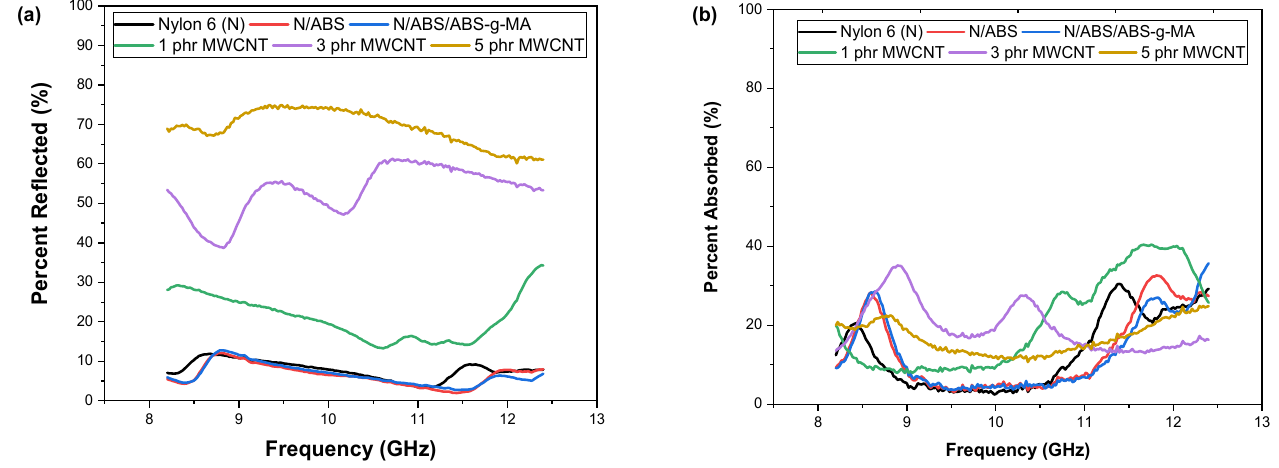
Figure 5. Contribution of reflection and absorption to electromagnetic wave attenuation for Nylon 6, blends, and nanocomposites. ( a ) Percentage by reflection for Nylon 6, ABS, blends and nano- composites. ( b ) Percentage by absorption for Nylon 6, ABS, blends and nanocomposites. N = Nylon